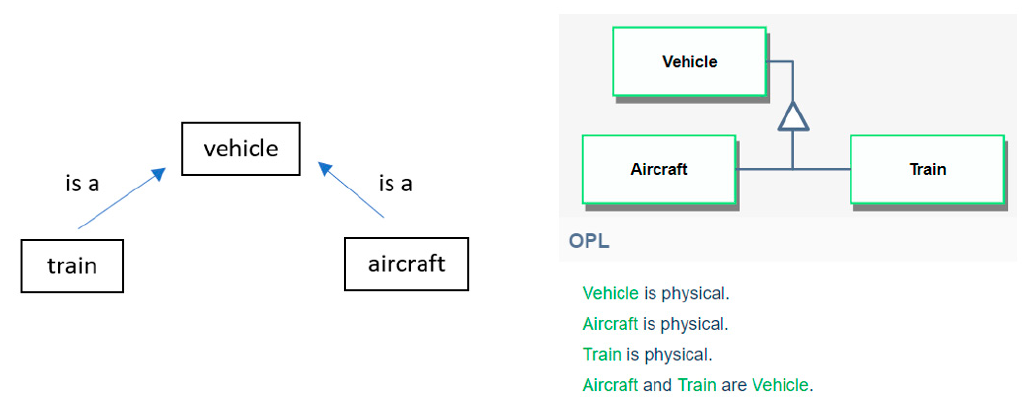
Figure 1. An example of the difference between a concept map (left) and an OPM model (right).